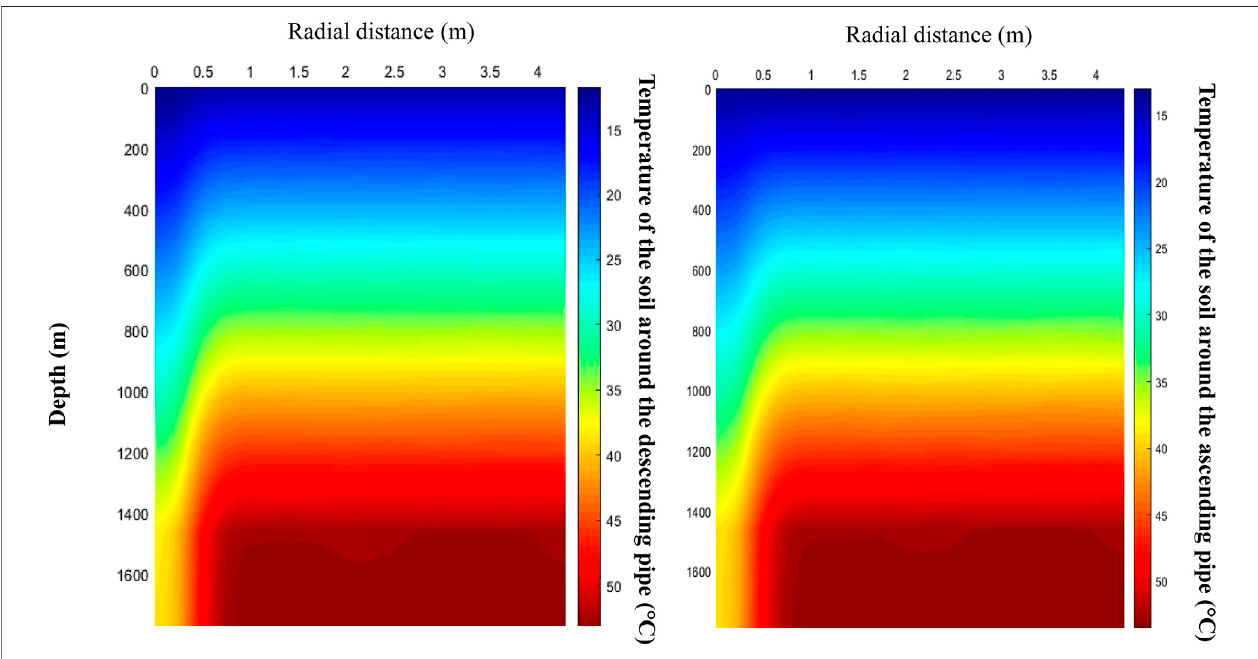
FIGURE 9 | Isotherm diagram of the soil around the vertical pipe.